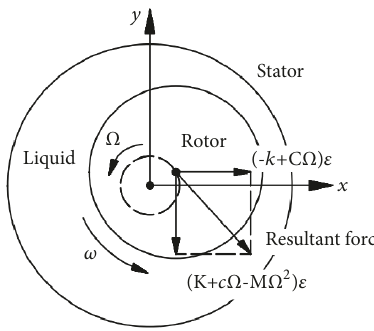
Figure 6: Whirling and rotating motions of a tested rotor and the forces on